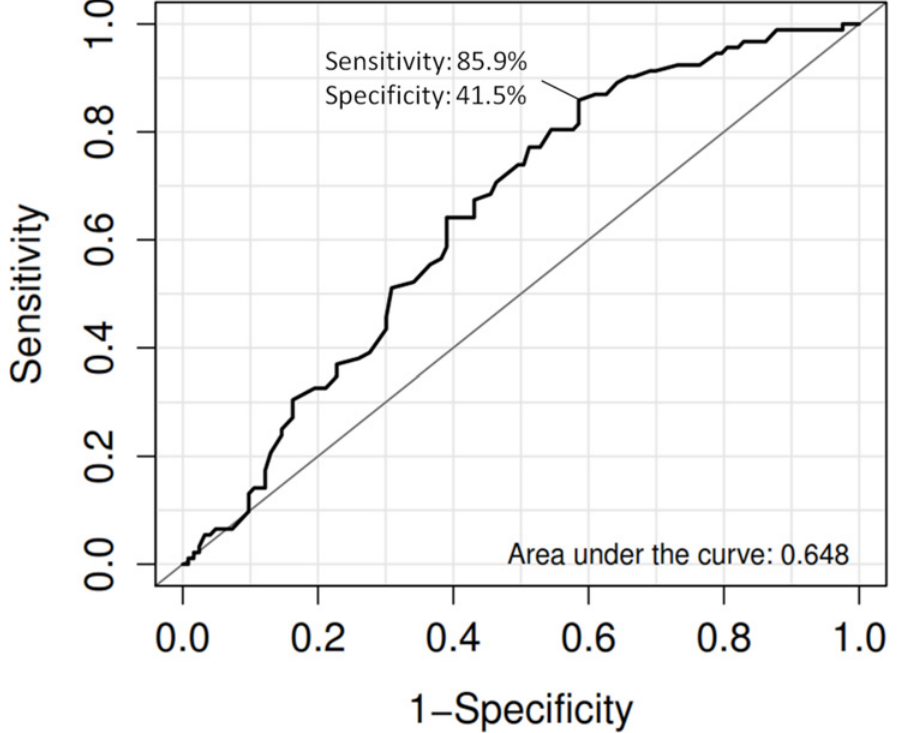
Fig 1. ROC curve of the combined effects of ABCG2 421C > A (Q141K) and age with severe